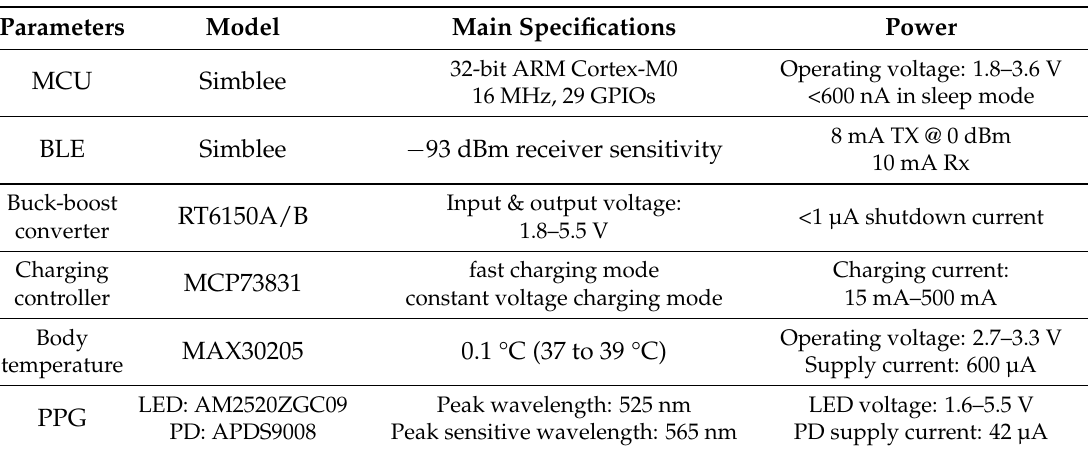
Table 2. Key components used in the Health